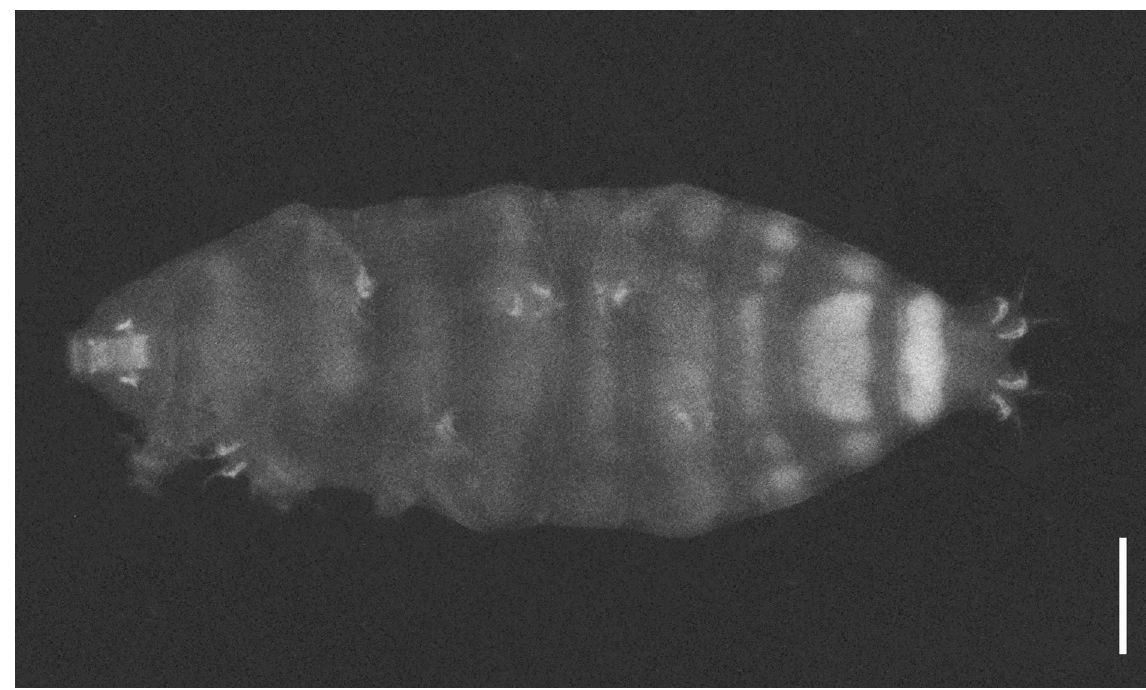
Fig. 14. Milnesium irenae sp. nov., paratype, ♀ (slide No. UNLPam 1430-1). View under UV fluorescence microscope, showing various pseudoplates. Scale bar = 50